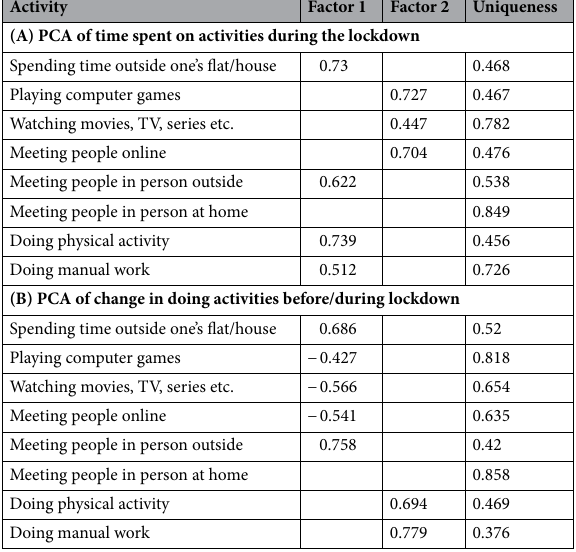
Table 1. Results of two principal components analyses (factor loadings and uniqueness) performed on the results of the lifestyle habits survey.